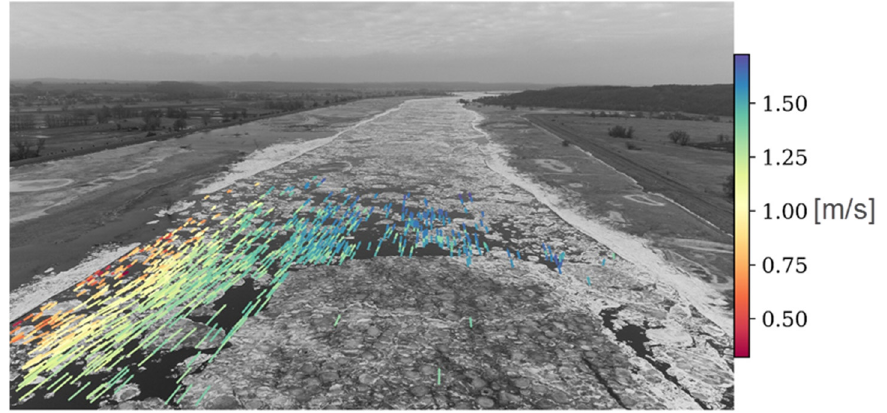
Figure 15. Trajectory and flow velocities of ice floes from the ice-jam event of February 2021 in the west channel of the lower Oder River (source: Technische Hochschule Nürnberg).